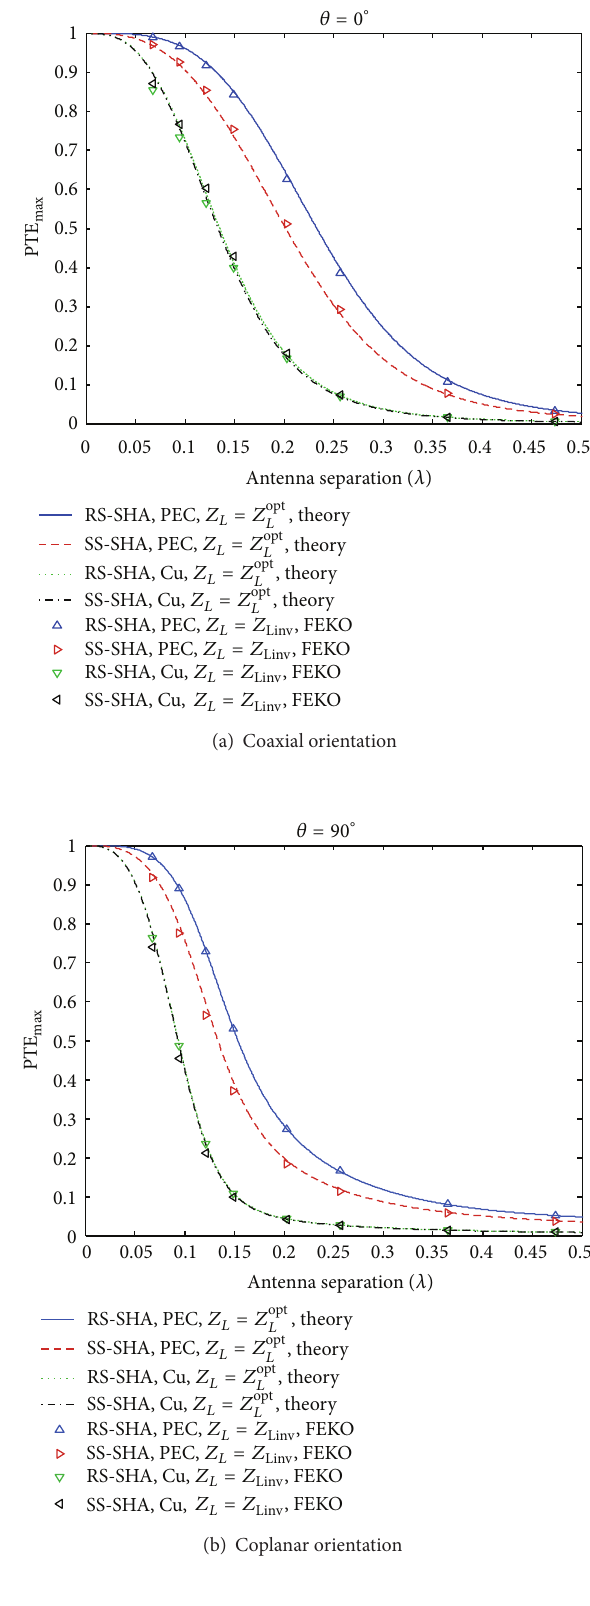
Figure 10: Maximum PTE in case of open-end SHA receivers with CARS-SHA